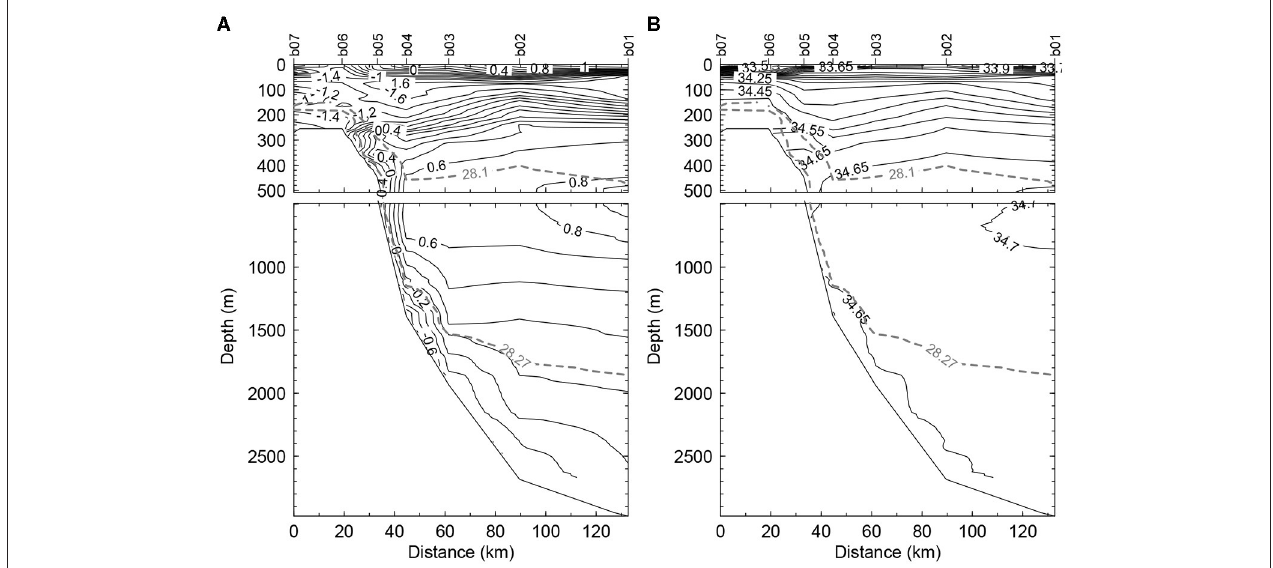
FIGURE 3 | Contours of (A) potential temperature and (B) salinity on transect B. The gray dashed lines indicate the contours of γ n .